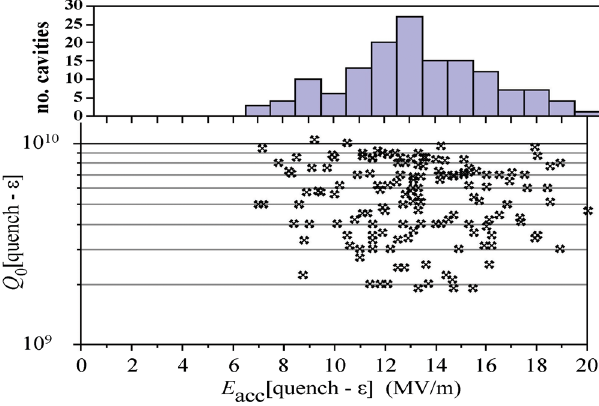
FIG. 4. Cavity performance just below quench during pair testing (from [48]).